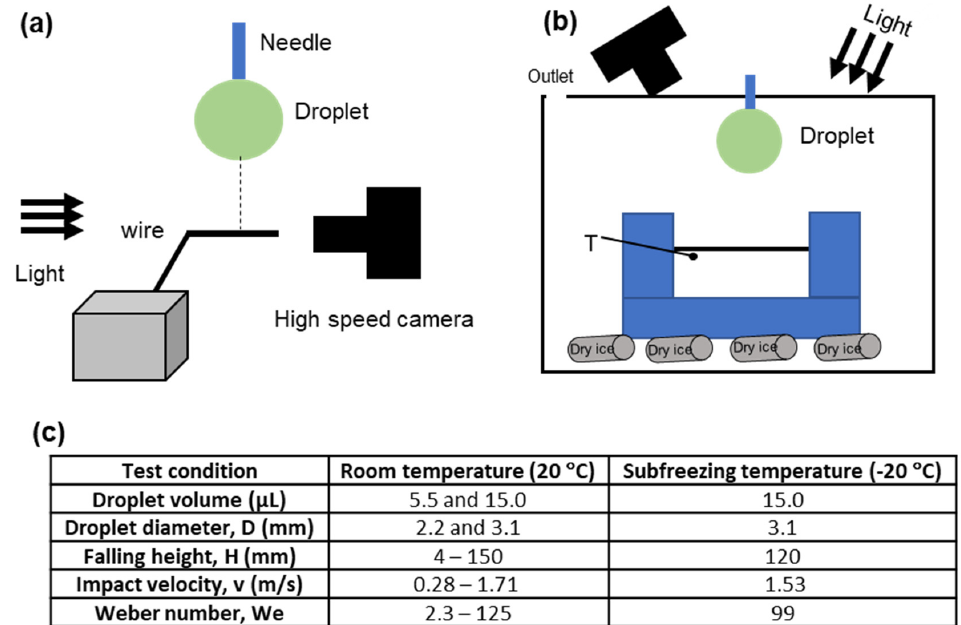
Figure 2. Schematic of the experimental setup and condition. ( a ) Experimental setup for the room temperature test. ( b ) Experimental setup for the low (subfreezing) temperature test. ( c ) Test conditions of a droplet for each test.